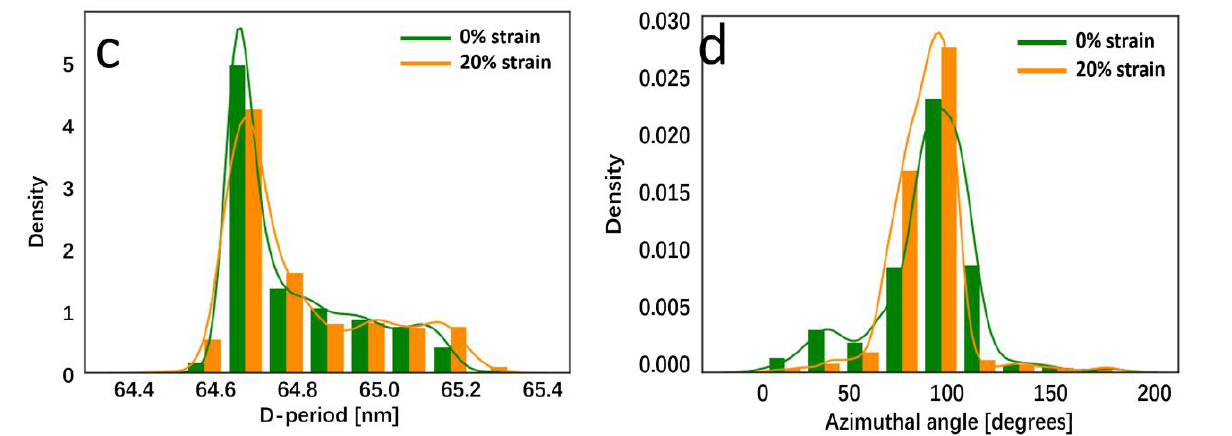
Figure 4. In situ tensile strain leads to variation of SAXS intensity contrast: ( a ) at 0% strain, collagen intensity mapping with the enlarged region of interest; dashed line is the scan size at 20% strain; ( b ) at 20% strain on same sample, collagen intensity mapping with the enlarged region of interest; ( c ) histogram of collagen D-period distribution at 0% and 20% strain; ( d ) histogram of collagen orientation angle at 0% and 20% strain. Smooth lines: kernel density estimators.